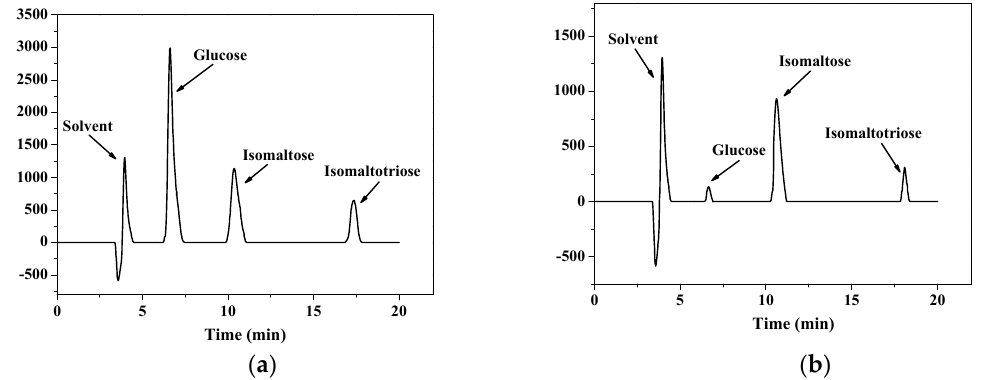
Figure 5. HPLC results for glucose, isomaltose and isomaltotriose ( a ); and for the final products of dextranase ( b ).